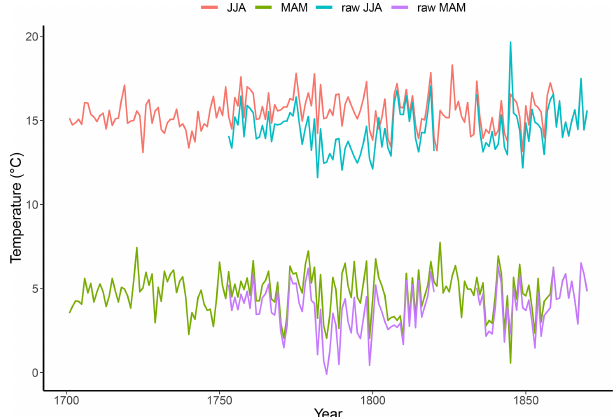
Figure 7. Raw and homogenized seasonal JJA and MAM mean temperatures at Lund, 1701–1870. Sources: Copenhagen (Cappe- len et al., 2019), Berlin–Dahlem (DWD, 2018), De Bilt (Durre et al., 2008; Lawrimore et al., 2011), Lund (Tidblom, 1876), Upp- sala (Bergström and Moberg, 2002), and Stockholm (Moberg et al., 2002; Moberg, 2021). Note: see Appendix A for a further dis- cussion of the homogenization process.